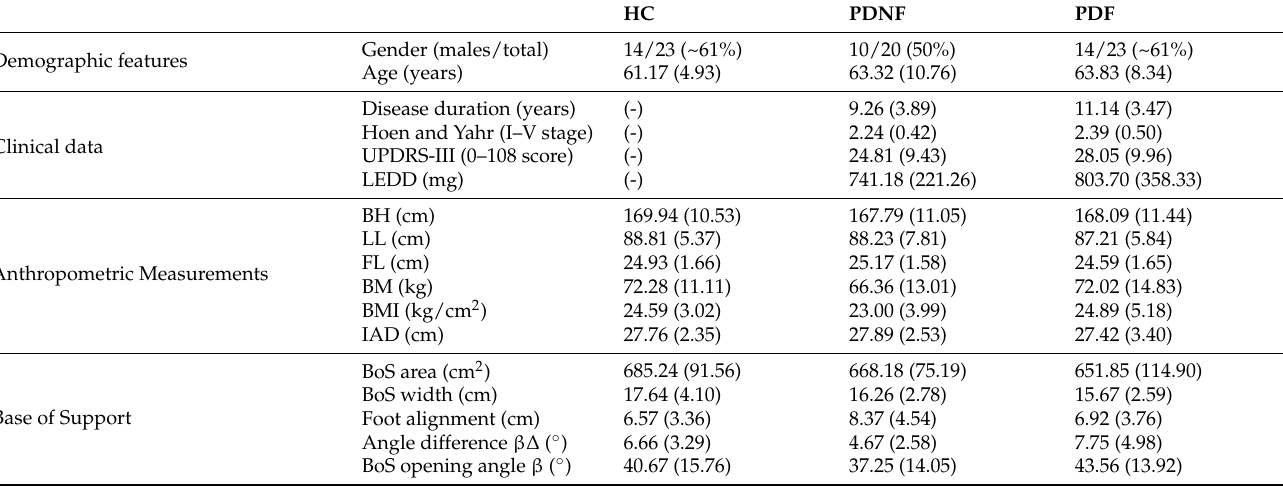
findings [12]. The GI variables that were independent from the BoS are listed in Table 3. The BoS and the AMs showed no correlations with the trunk, thigh, and shank angles. Table 2. Demographic, clinical, anthropometric, and base of support features. Data are shown as mean (standard deviation). No statistically significant difference was found across groups (Mann– Whitney U-test, p -value set at 0.05). Abbreviations: HC, healthy controls; LEDD, levodopa equivalent daily dose; PDF, Parkinson’s disease with freezing of gait; PDNF, Parkinson’s disease with no freezing of gait; UPDRS-III, Unified Parkinson’s Disease Rating scale, part III. Refer to Table 1 for a list of other abbreviations used.